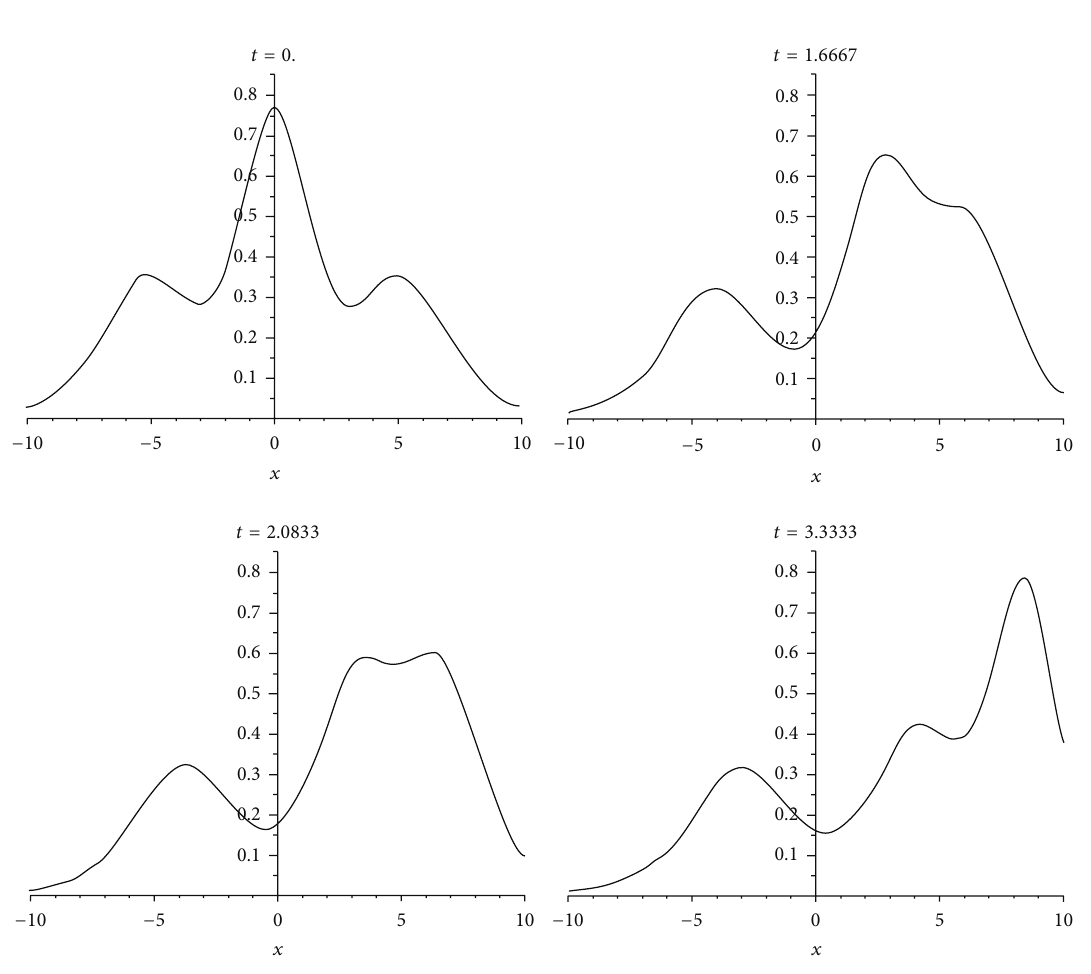
Figure 6: The interaction of three